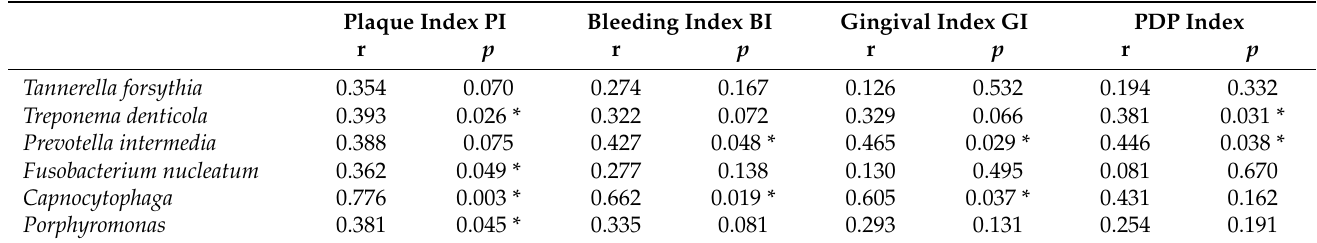
Table 5. Correlation between the bacteria amount and the periodontal disease. Plaque Index PI Bleeding Index